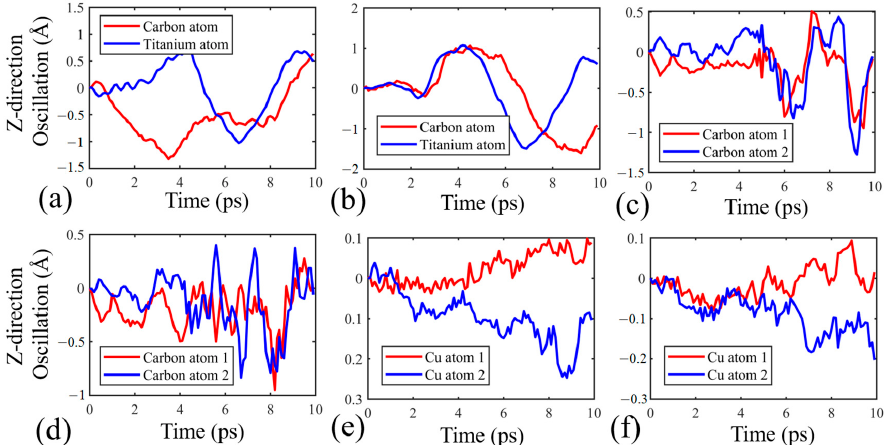
Figure 4. Z-direction oscillation of adjacent carbon and titanium atoms located at the highlighted position in Figure 1a of the Ti 8 C 5 nanosheet under impact velocities of ( a ) 3 km/s and ( b ) 6 km/s; z-direction oscillation of 2 carbon atoms in graphene nanosheets (similar position as the Ti 8 C 5 ) under impact velocities of ( c ) 3 km/s and ( d ) 6 km/s, respectively; z-direction oscillation of 2 copper atoms (similar position as the Ti 8 C 5 ) under impact velocities of ( e ) 3 km/s and ( f ) 6 km/s,